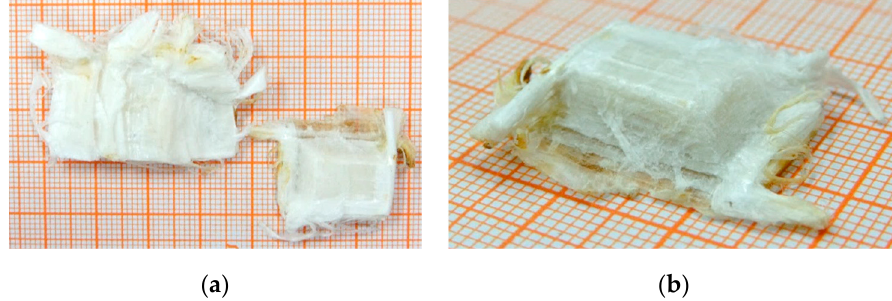
Figure 5. The failure pattern of the bigger specimen: ( a ) top view of the two pieces; ( b ) shear failure feature.